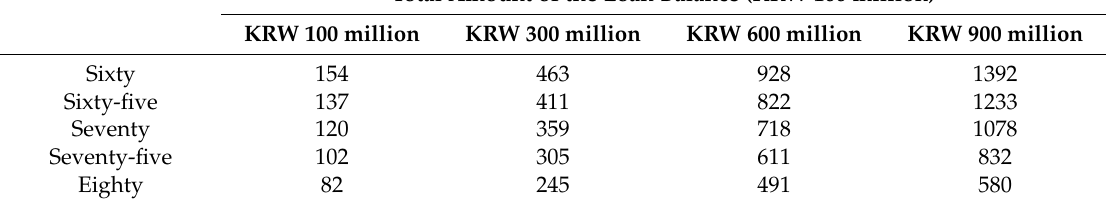
Table 2. Reverse mortgage loan balance until age of life expectancy by age group and house price level. This table presents the estimated total amount of reverse mortgages if the borrower survives to the point of life expectancy. The Korea Housing Finance Corporation adjusts the monthly payments of reverse mortgages every year considering house prices, interest rates, and life expectancy. Total Amount of the Loan Balance (KRW 100